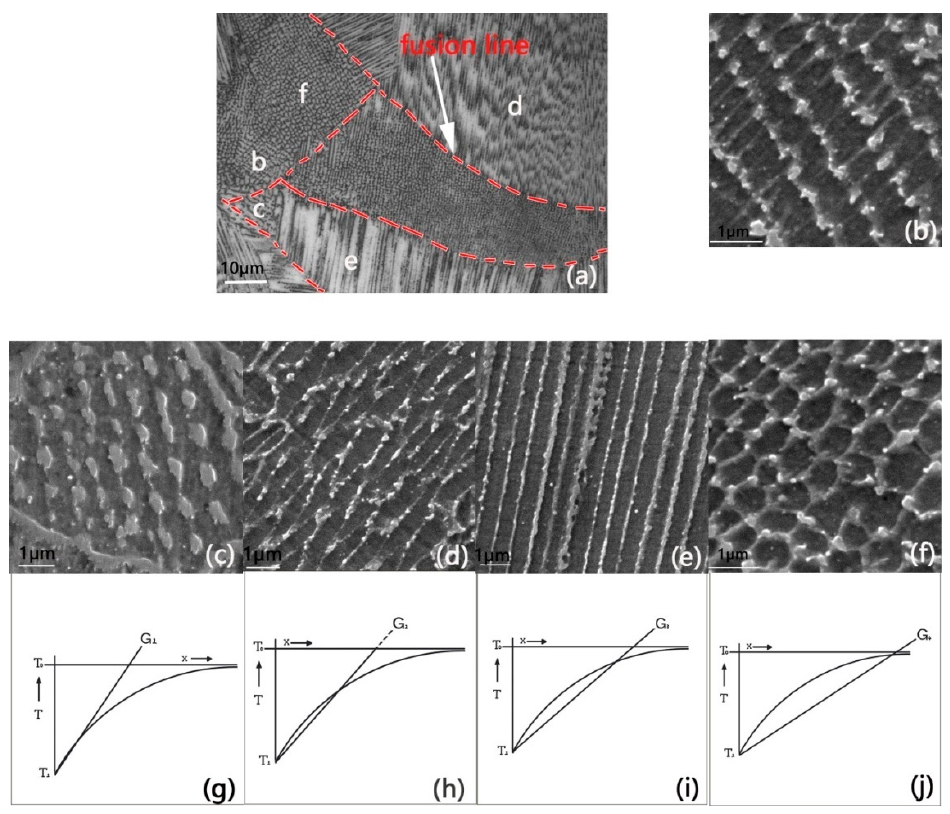
Figure 3. ( a ) Scanning electron microscopy (SEM) of one region of the XZ section of the sample. ( b ) Cellular dendrite. ( c ) node cell structure. ( d ) irregular cell structure. ( e ) elongated cell structure. ( f ) hexagonal cell structure. ( g – j ) diagrammatic sketches of the undercooling of ( c – f ), respectively.